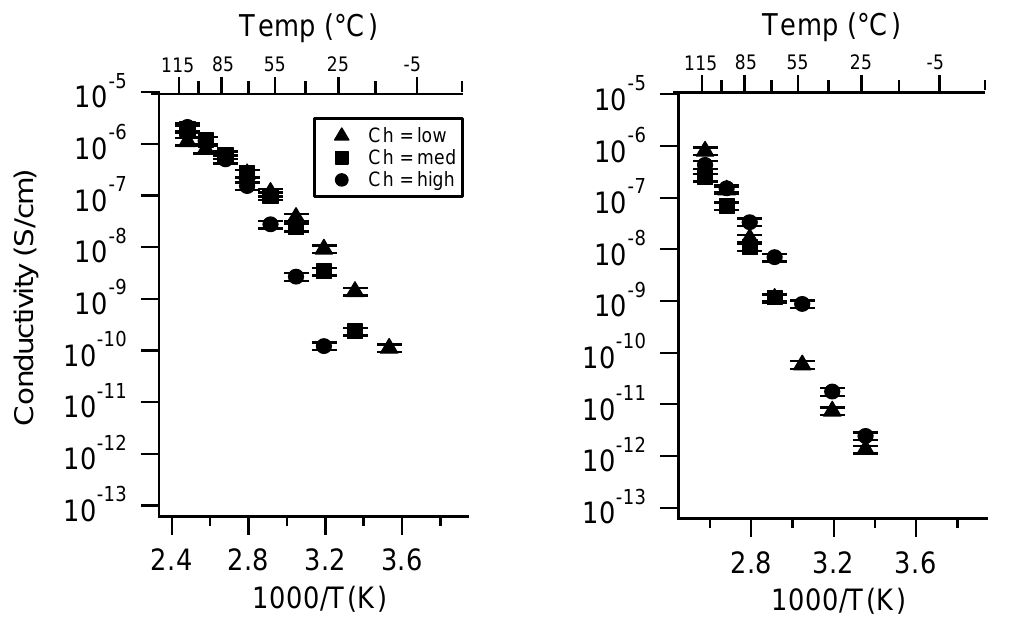
Figure A20. Conductivity as a function of charge density for PEGDMA1000_SSCa (left) and PTHFDA1000_STFSICa (right) SIPEs swelled with ECPC. Temperatures ranged from − 20 °C to 115 °C.